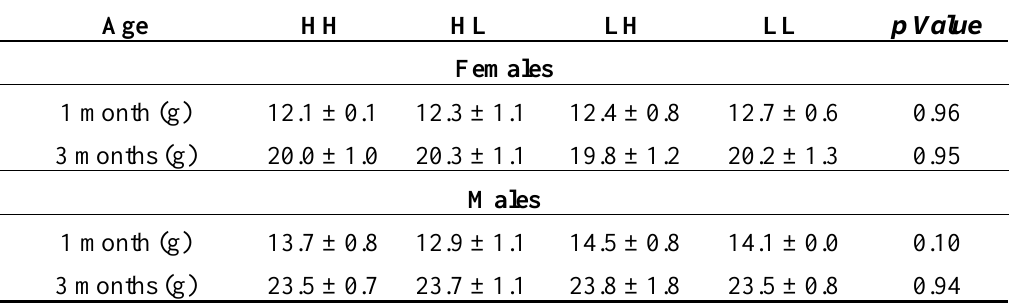
Table 2. Body weight of offspring at 1 month of age (weaning) and 3 months of age